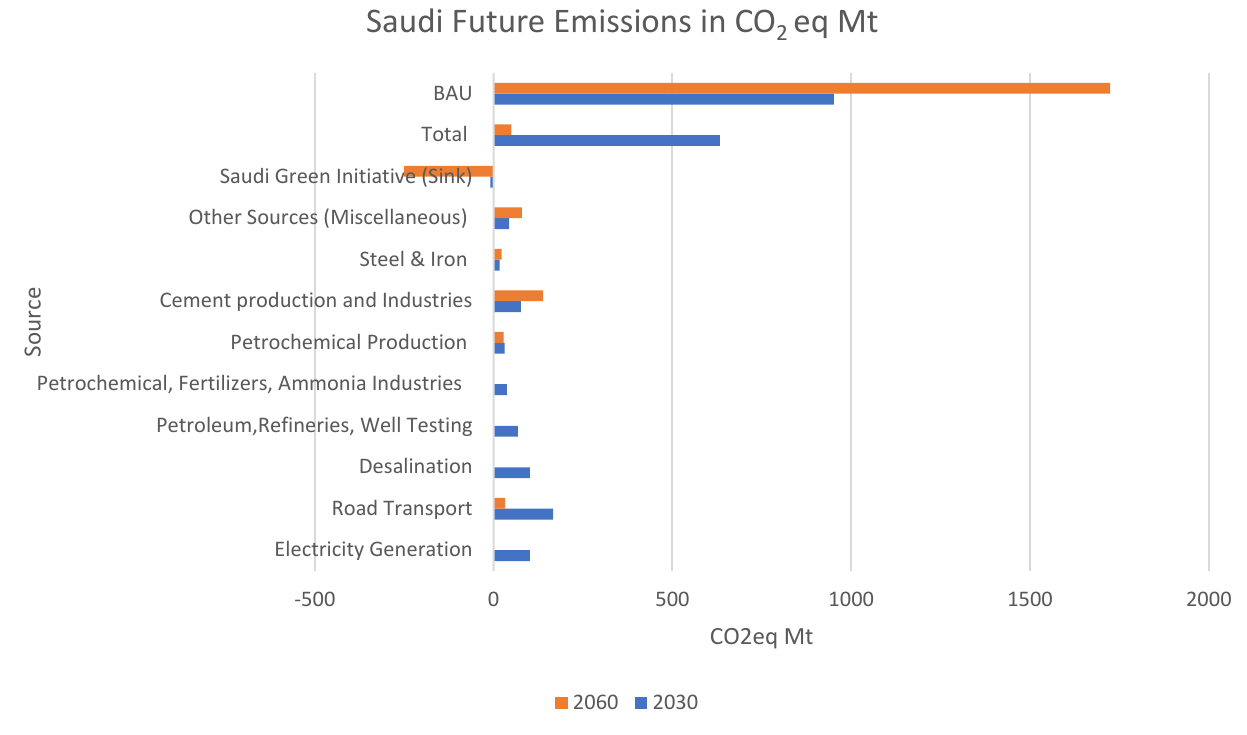
Figure 13. Forecast of Saudi emissions in 2030 and 2060.